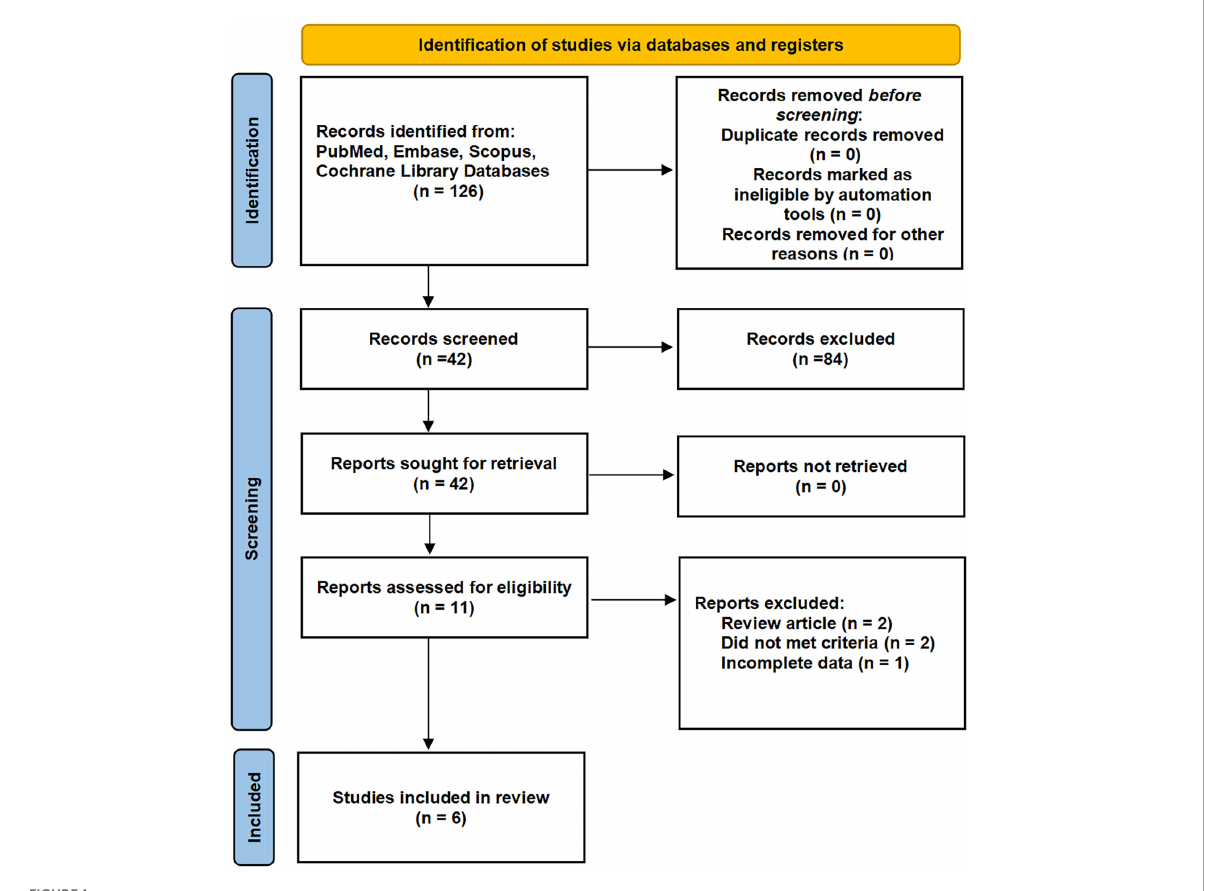
FIGURE1 Flow diagram of the studies selection